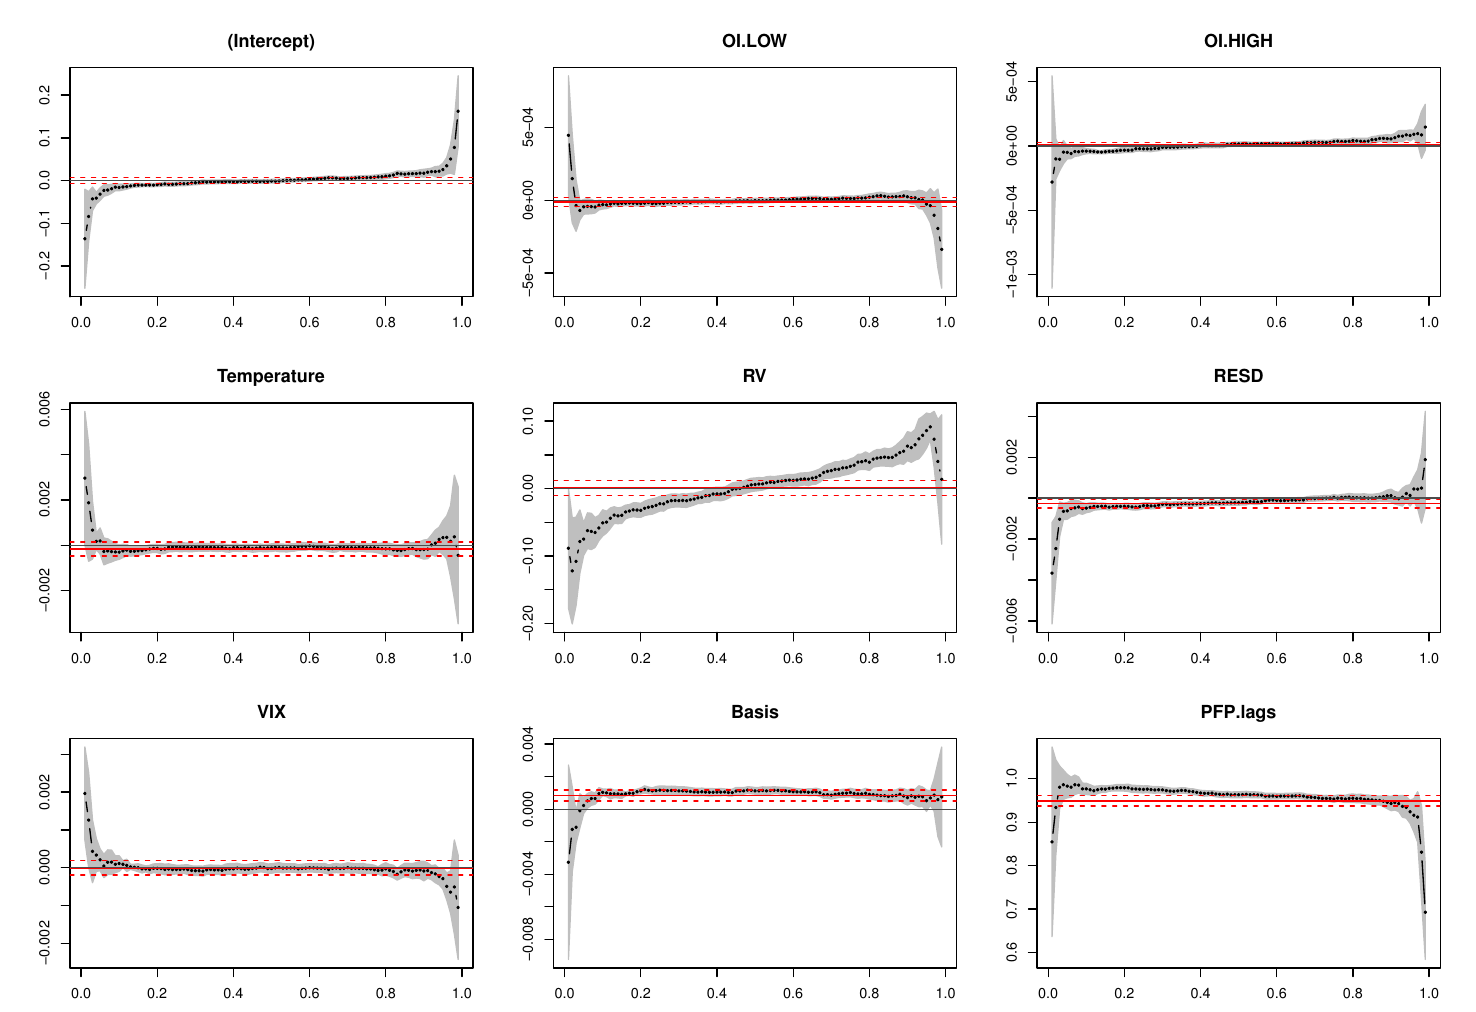
Figure 4. Quantile regression coefficients plotted for various quantiles with percentage forward premium as the dependent